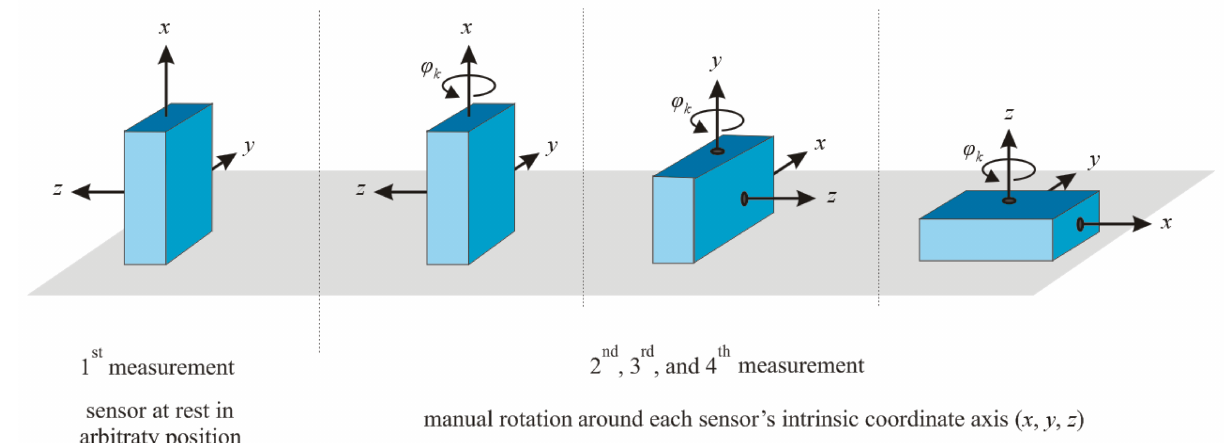
Figure 10. Orientations of the 3D gyroscope during the four calibration measurements